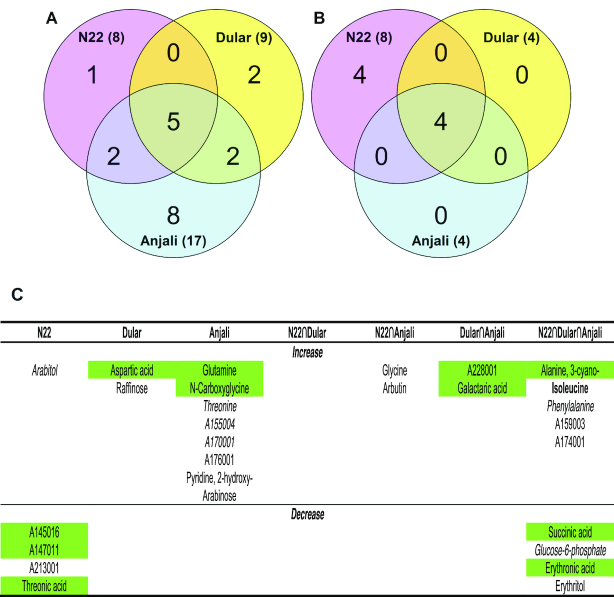
Common and cultivar-specific stress-responsive metabolites in developing seeds. (A, B) Numbers of common and cultivar-specific metabolites in developing seeds that showed significant (Mann-Whitney-Wilcoxon test, P < 0.05) increases (A) or decreases (B) in abundance under severe stress relative to well-watered controls. The corresponding metabolites are listed in (C). Metabolites highlighted in green showed specific responses to severe stress in developing seeds compared with flowering spikelets; metabolites in italics are those that have similar cultivar-specific responses across the 2 organs, and boldface indicates metabolites with a common response with flowering spikelets among all cultivars (Fig. 10). 4-Hydroxyphenyl-β-glucopyranoside is listed as arbutin.